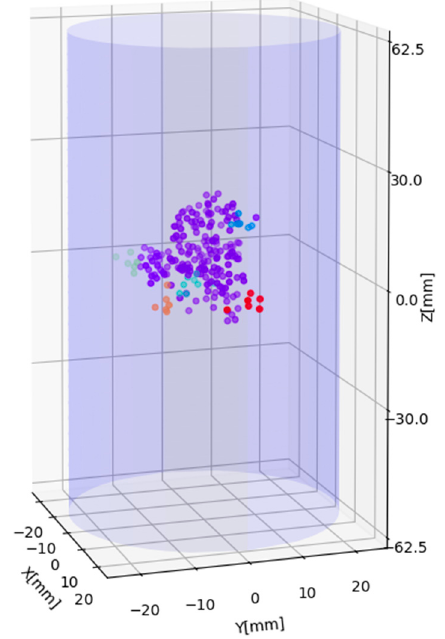
Figure 17. ST ‐ DBSCAN space ‐ time clustering results of the acoustic emission events positioning results.